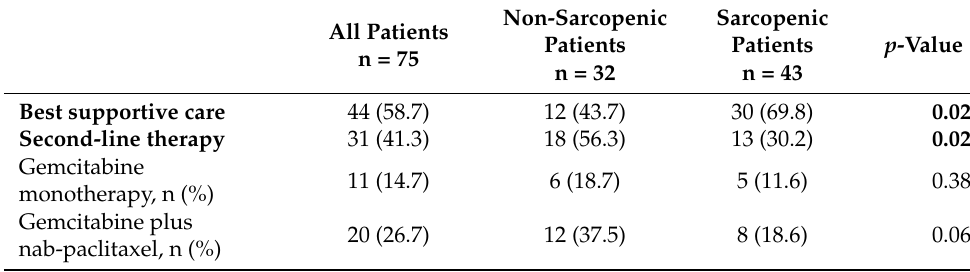
Table 5. Treatment at progression after